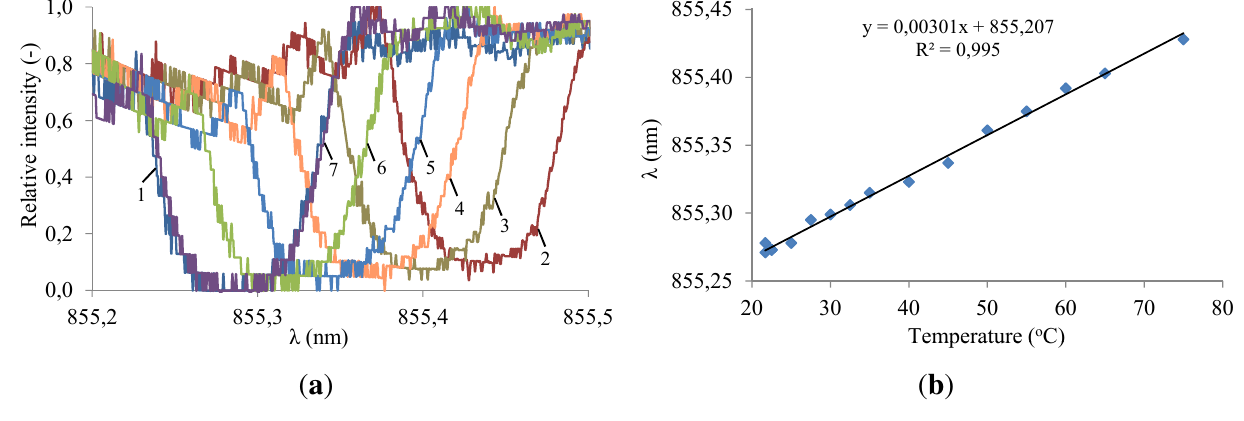
Figure 13. Temperature characterization of the fully embedded system. ( a ) 1: 21.7 °C (RT), 2: 75 °C, 3: 65 °C, 4: 55 °C, 5: 45 °C, 6: 35 °C, 7: 25 °C. Measured transmission spectra using the integrated VCSEL and photodetector system; ( b ) Wavelength extremum versus